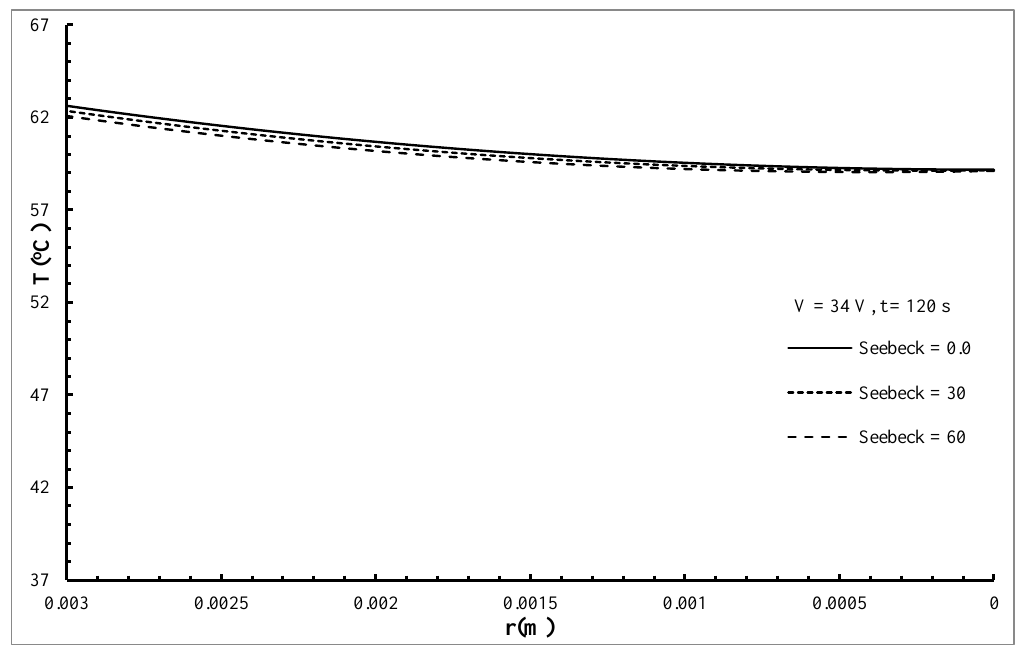
Figure 2. The absolute temperature distribution of myxoid liposarcoma tumor with various values of Seebeck coefficient when 34V, 75 Ω, 120s